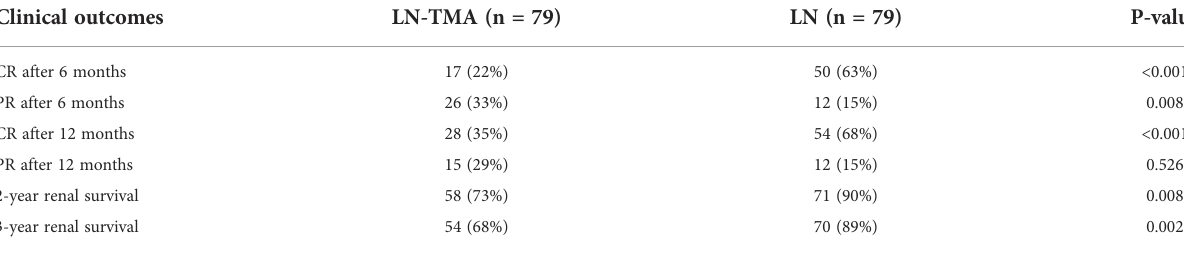
TABLE 5 Clinical outcomes of lupus nephritis patients with or without renal thrombotic microangiopathy. Clinical